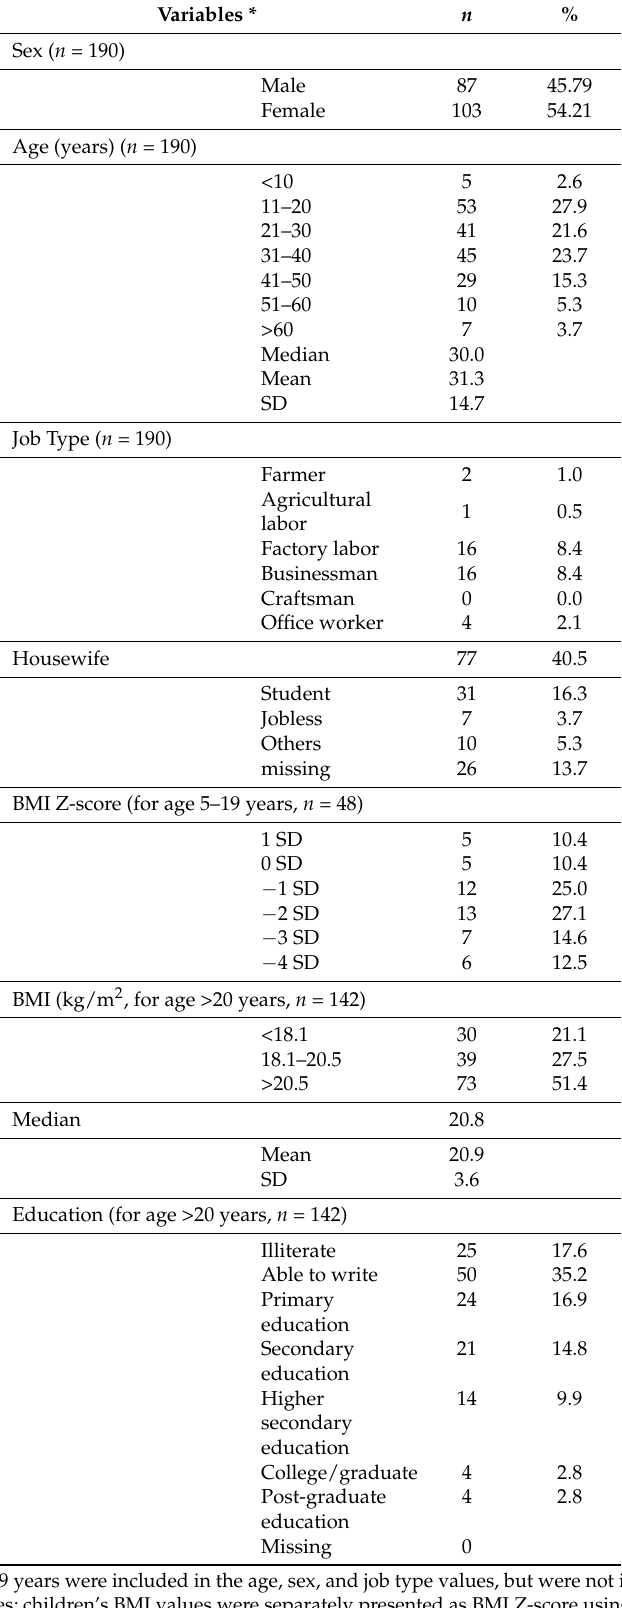
Table 1. Socio-demographic characteristics of study